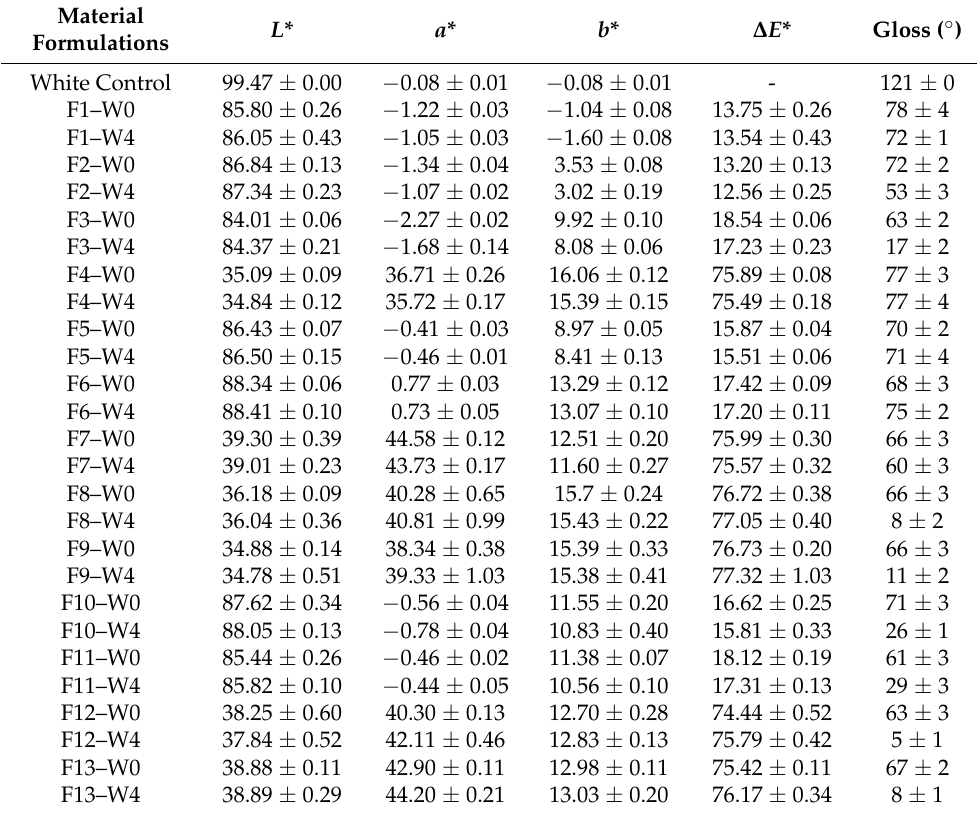
Table 3. Color coordinates and gloss of polybutylene succinate (PBS) based systems at W0 and